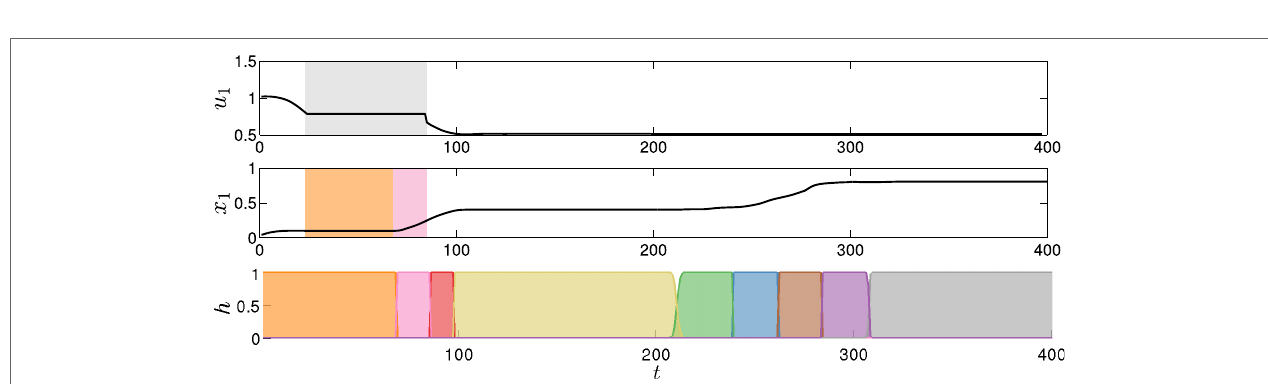
FIGURE 6 | Evolution in time of the rescaled forward variable h t,i during the handover task . The temporal dynamics of the task is autonomously adapted according to the interaction with the user.